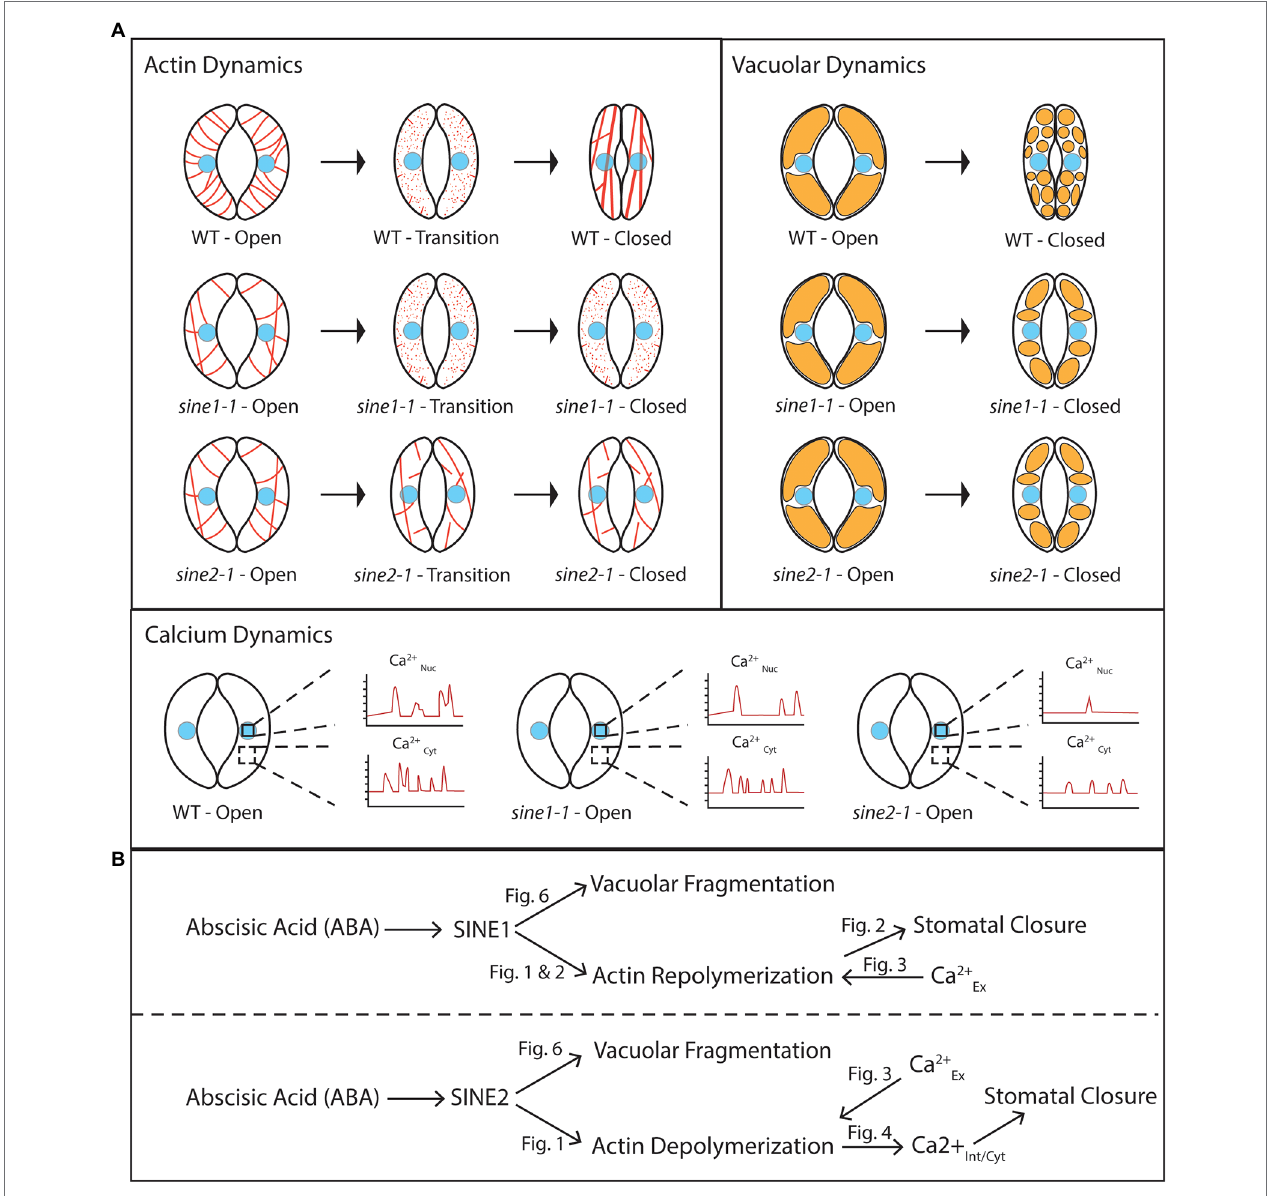
FIGURE 8 | SINE1 and SINE2 have differential roles in ABA-induced guard cell closure. (A) Cartoon depicting subcellular dynamics during stomatal closure in WT and sine mutants. The cell nucleus is colored light blue. Actin is depicted in red, and vacuoles in orange. Ca Nuc , nuclear calcium fluctuations; Ca Cyt , cytoplasmic calcium fluctuations. (B) A working model proposing roles for SINE1 and SINE2 in stomatal closure based on the data shown here. “Fig” labels indicate figures showing the supportive experiment(s). Calcium ex , externally applied calcium; calcium int/nuc , internally measured nuclear calcium; calcium int/cyt , internally measured cytoplasmic calcium. For details, see